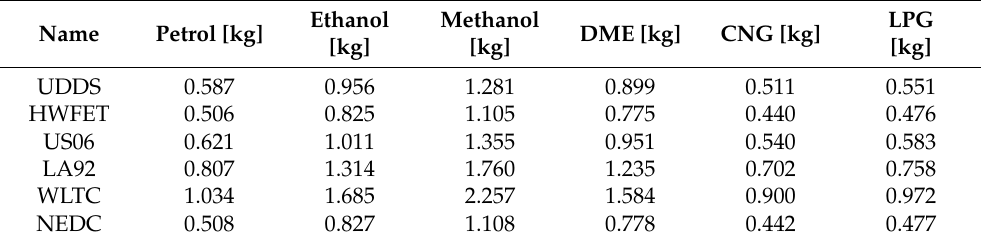
Table 6. Summary of the final consumption of the tested fuels obtained from simulations of the 2018 Toyota Camry LE vehicle for selected road tests.